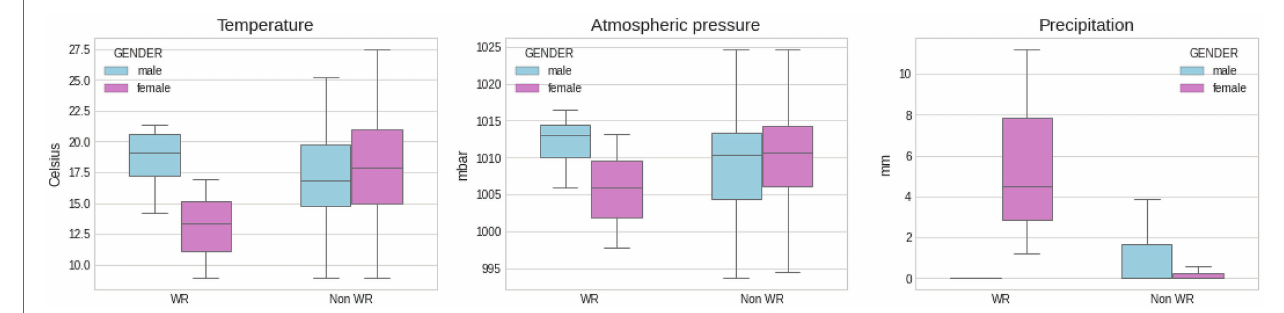
FIGURE 5 | Comparative analysis of weather conditions [temperature ( ° Celsius), atmospheric pressure (mbar), and precipitation (mm)] on WR marathon performances and non WR marathon performances by gender, with SD. About 95% CI was used to create the boxplots. Statistical differences between female WR precipitation and all groups ( p <